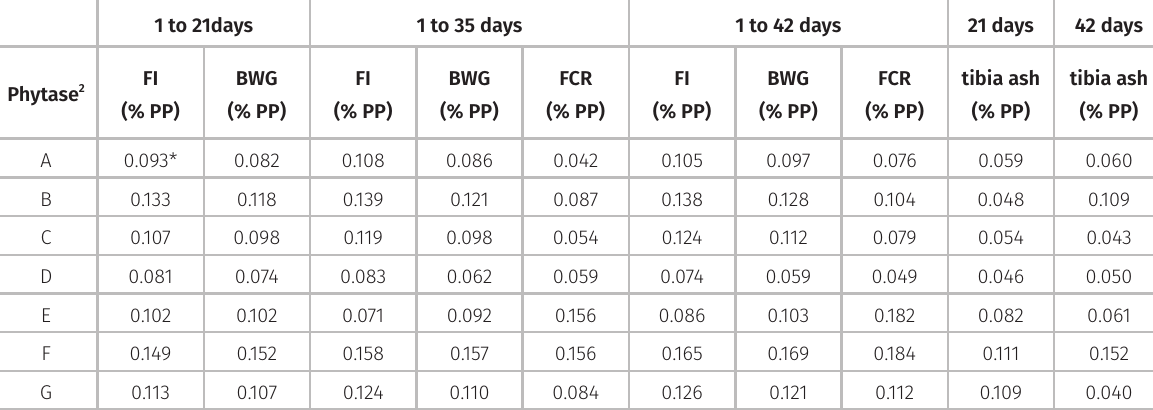
Table V. Estimated phytate phosphorus (PP) release of different commercial phytases supplemented to broilers considering feed intake (FI), body weight gain (BWG), feed conversion ratio (FCR) and tibia ash evaluated in different periods 1